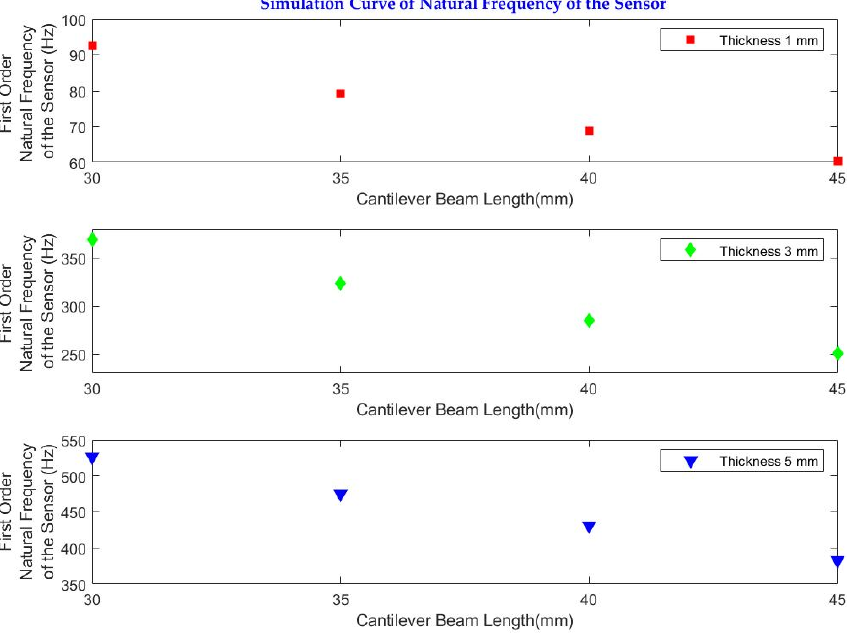
Figure 7. Sensitivity analysis of natural frequency values for different cantilever beam lengths and thicknesses.